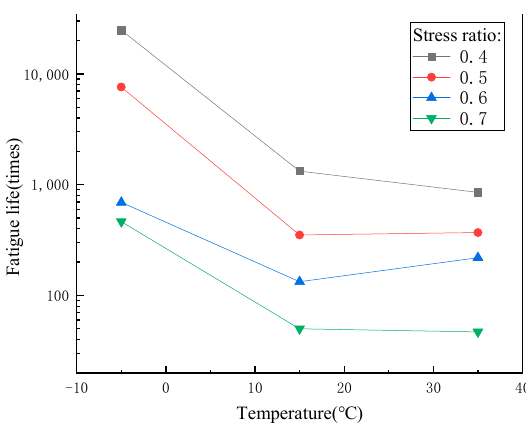
( a ) Variation trend of fatigue life with temperature.